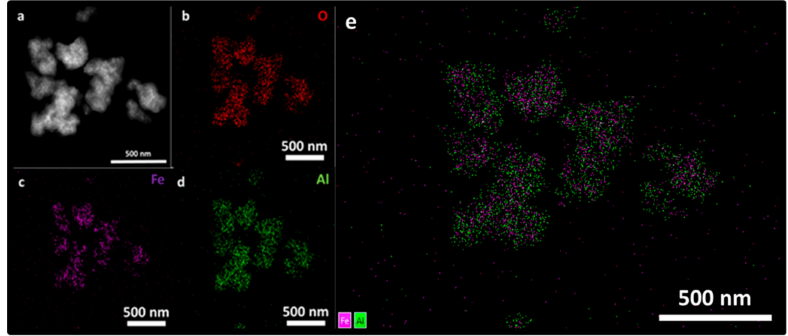
Figure 6. ( a ) STEM micrograph and mapping with energy dispersive X-ray (EDX) emitted by the elements present in the Fe 3 O 4 @Al(OH) 3 samples: ( b ) oxygen, O ( c ) iron, Fe, ( d ) aluminum, Al, and ( e ) overlay of Fe (purple color) and Al (green colour)